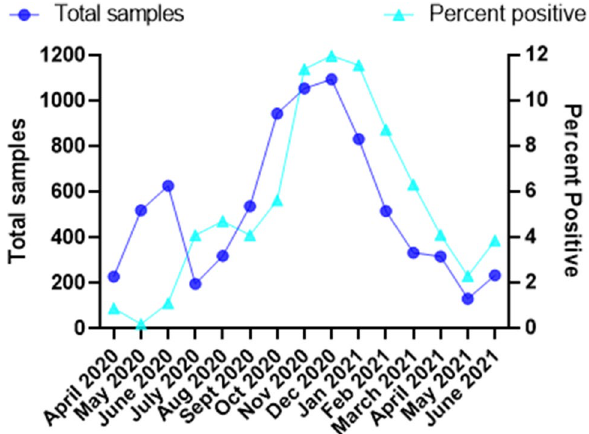
Figure 2. SARS-CoV-2 RT-PCR Occupational testing using the Sandia National Laboratories SNL-NM 2019 nCoV Real-Time RT PCR Diagnostic Assay (EUA200481). Total occupational samples tested between April 2020 and June 2021 and the percent positive of these samples.